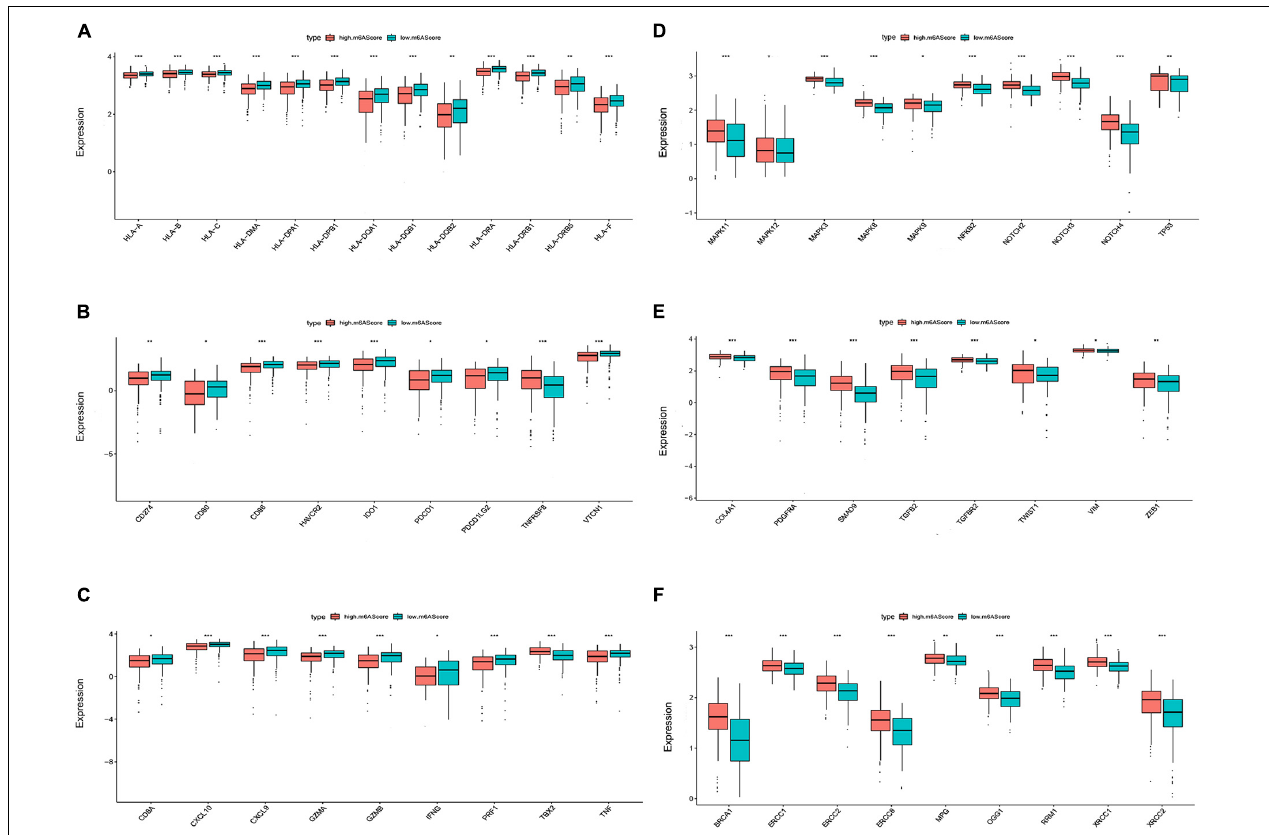
FIGURE 5 | Biological phenotypes associated with the m6A score in ovarian cancer. Differential expression of human leukocyte antigen (HLA) genes (A) , immune checkpoint molecules (B) , immune activation - related genes (C) , proliferation-related genes (D) , DNA repair-related genes (E) , and transforming growth factor